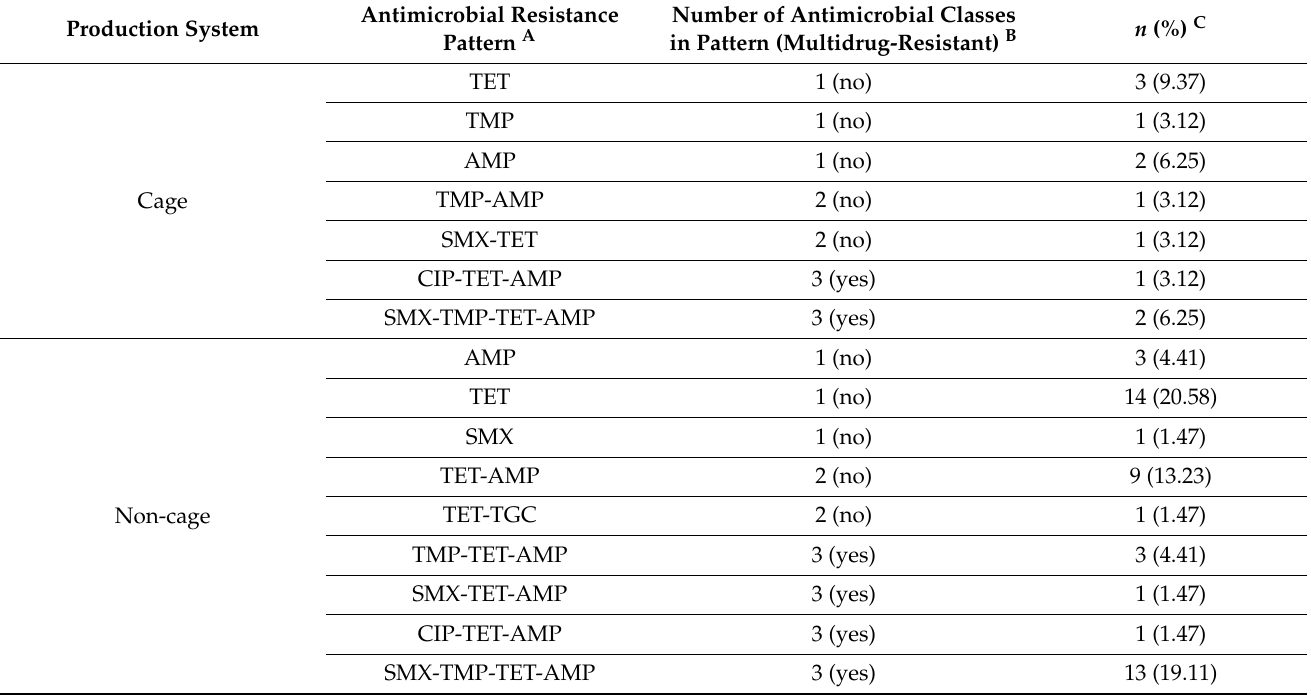
Table 2. Antimicrobial resistance patterns of commensal E. coli ( n = 100) isolated from retail table eggs of the cage and non-cage housing systems in Western